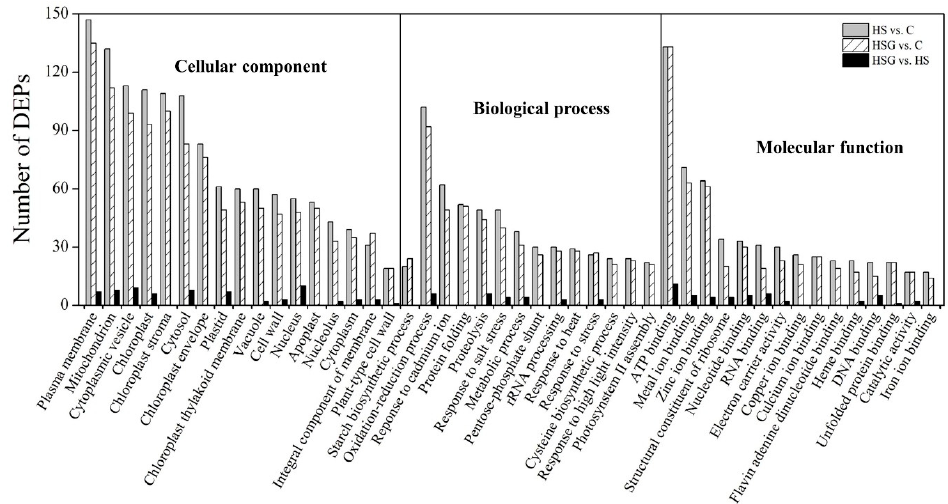
Figure 6. Gene Ontology (GO) analysis of differentially expressed proteins (DEPs) in leaf of creeping bentgrass in response to exogenous γ -aminobutyric acid (GABA) and heat stress. C, control (normal condition); HS, heat stress; HSG, heat-stressed plants pretreated with GABA. Molecules 2020 , 25 , x FOR PEER REVIEW